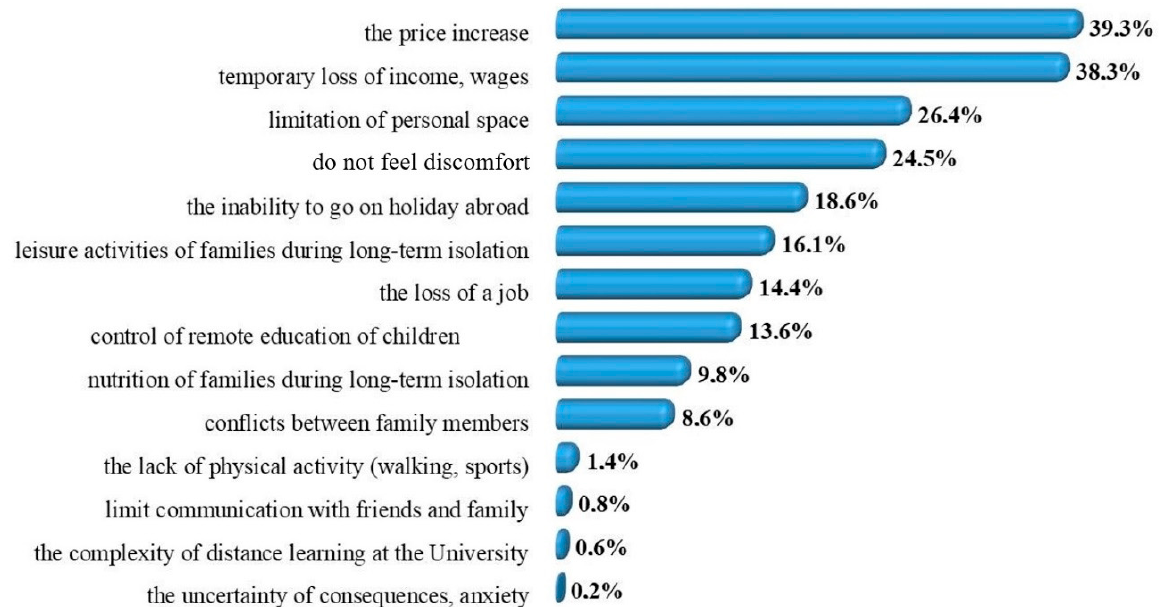
Figure 1. Reasons for the state of discomfort among respondents in self-isolation (the sum of indicators as a percentage is not equal to 100% due to the open format of the question and multiple answers).